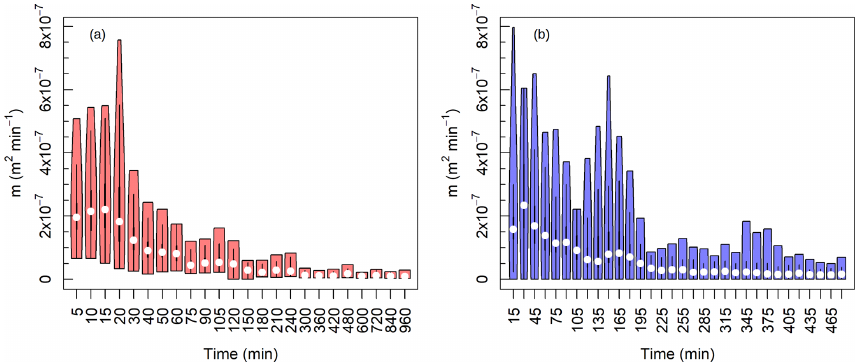
Figure 7. Violin plots showing the distribution of every cross-sectional value of morphologic activity for the (a) fixed-bank and (b) mobile- bank experiments for each DoD. Median values are given by the white point, kernel density by the internal lines, and the total range of values by the coloured box.